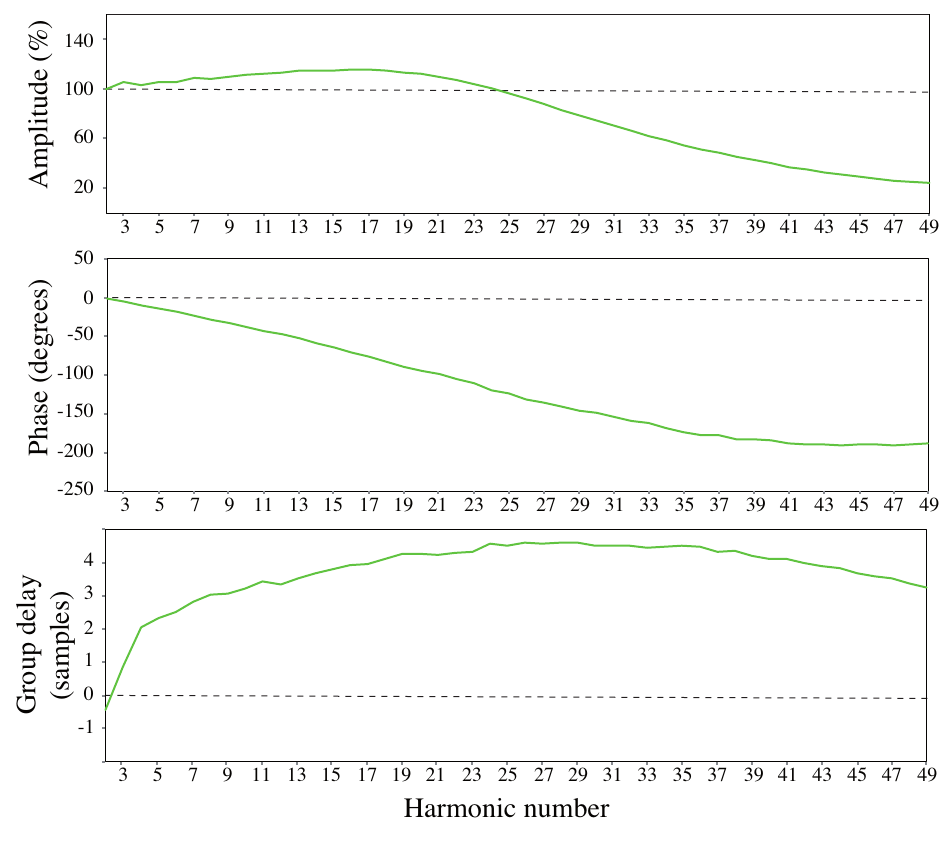
Figure 11. Experimental closed-loop frequency response and group delay for the CCF scheme with PI and grid-voltage feedforward